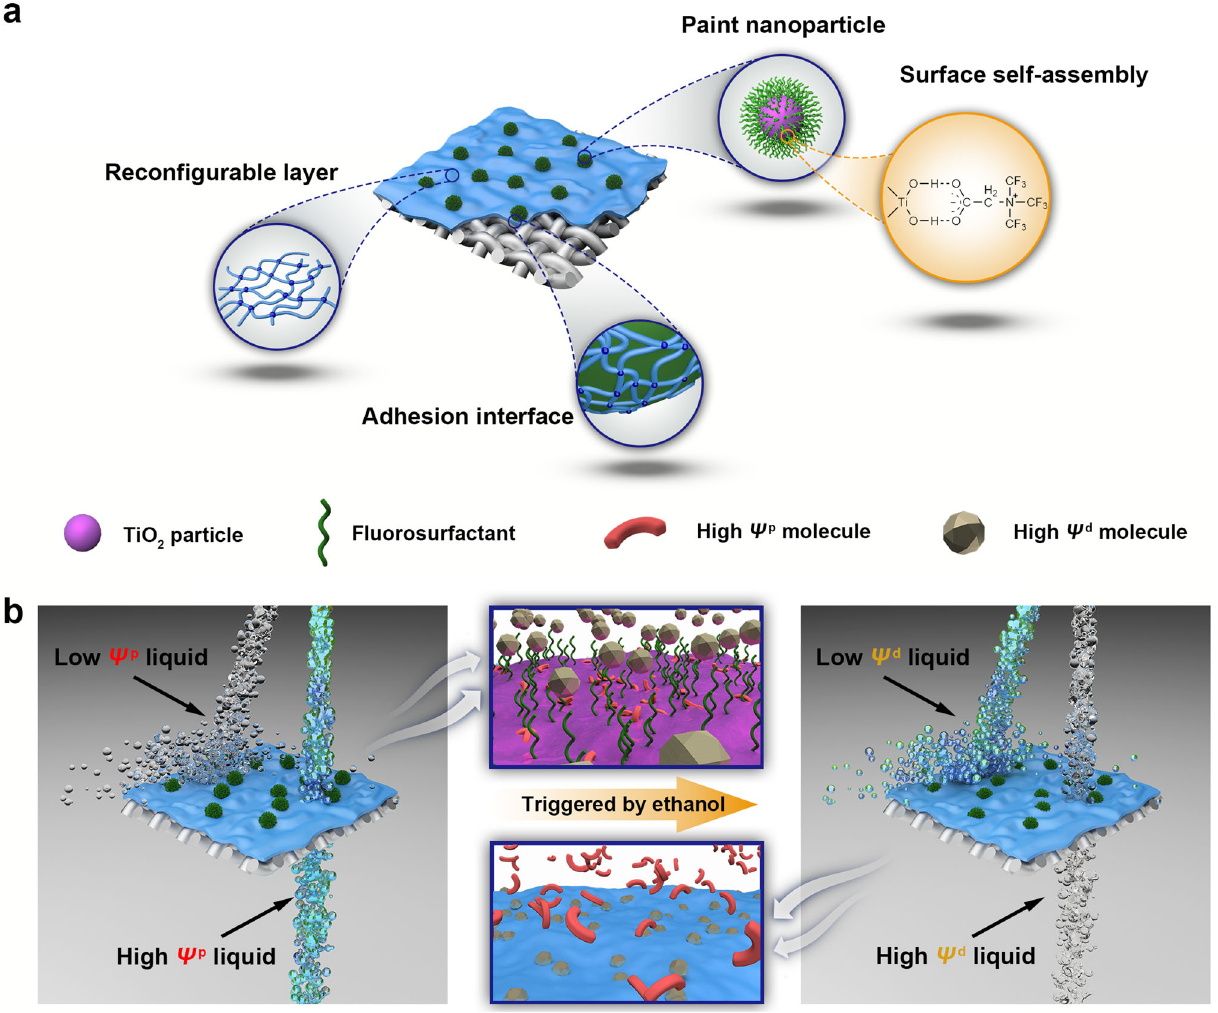
Fig. 1 Schematic illustration of the recon fi gurable membrane with tunable organic liquid (OL) wettability. a The microstructure of the recon fi gurable membrane. b On-demand OL separation procedures: the recon fi gurable membrane demonstrates the lyophobicity for the low polar surface energy component index (SECI, Ψ p ) liquids and the lyophilicity for the high polar SECI liquids. After the joystick liquid (ethanol) triggers, the membrane will adopt an opposite wetting mode to accomplish OL separation based on the difference of dispersive SECI ( Ψ d